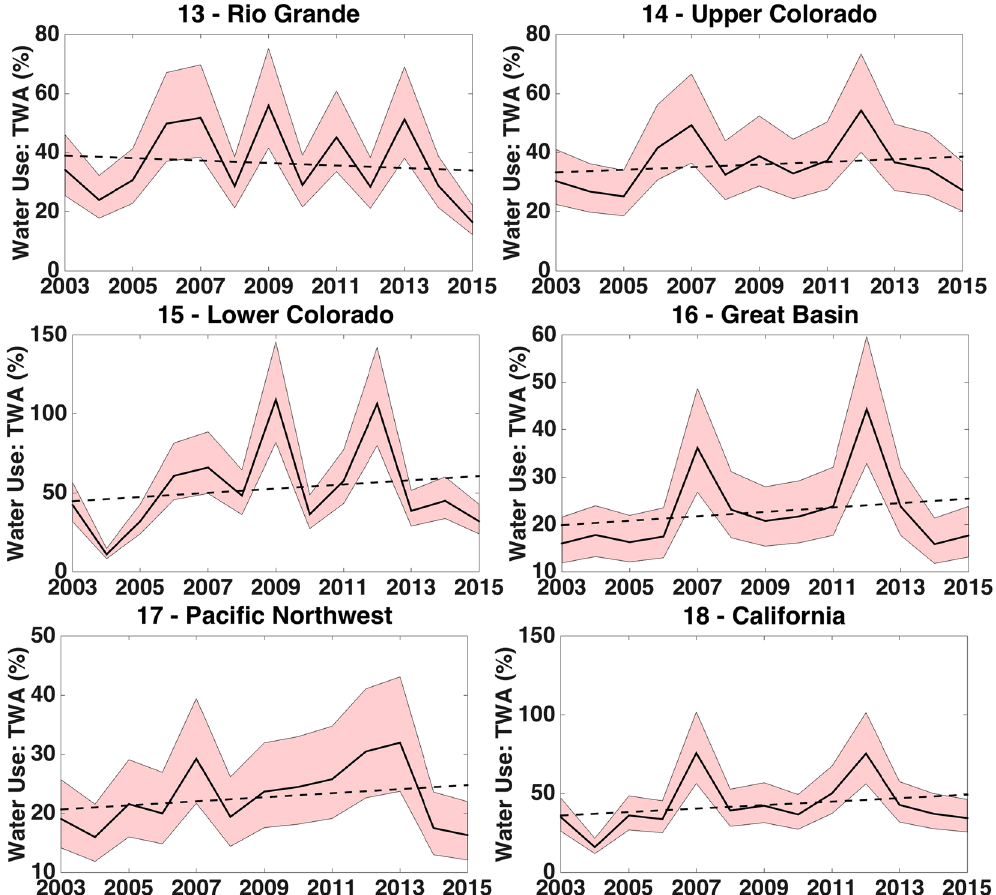
Figure 4. 2003–2015 time series of percent consumptive water use to availability ratios for the southwest two-digit HUC regions. Solid black line represents results obtained when median environmental coefficient of 0.5 and water efficiency ratio of 0.6 were used. Associated linear trends (dashed black line) in water use to availability fractions are as follows: ( − 0.42% yr − 1 , p-value = 0.67), 14 Upper Colorado (0.44% yr − 1 , p-value = 0.51), 15 Lower Colorado (1.33% yr − 1 , p-value = 0.55), 16 Great Basin (0.47% yr − 1 , p-value = 0.48), 17 Pacific Northwest (0.34% yr − 1 , p-value = 0.41), and 18 California (1.10% yr − 1 , p-value = 0.39). Shaded regions indicate possible estimates given full range of parameter